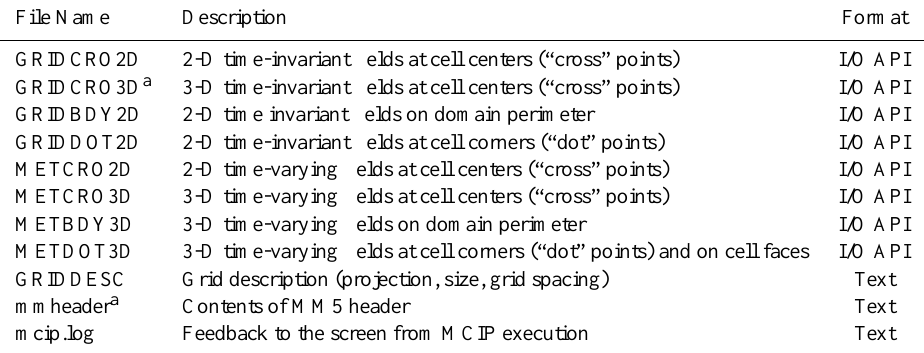
Table 2. Files that are output by MCIP. The relative locations of the fields can be obtained from Fig. 2a (dot points and cross points) and Fig. 2b (cell faces and cross points).